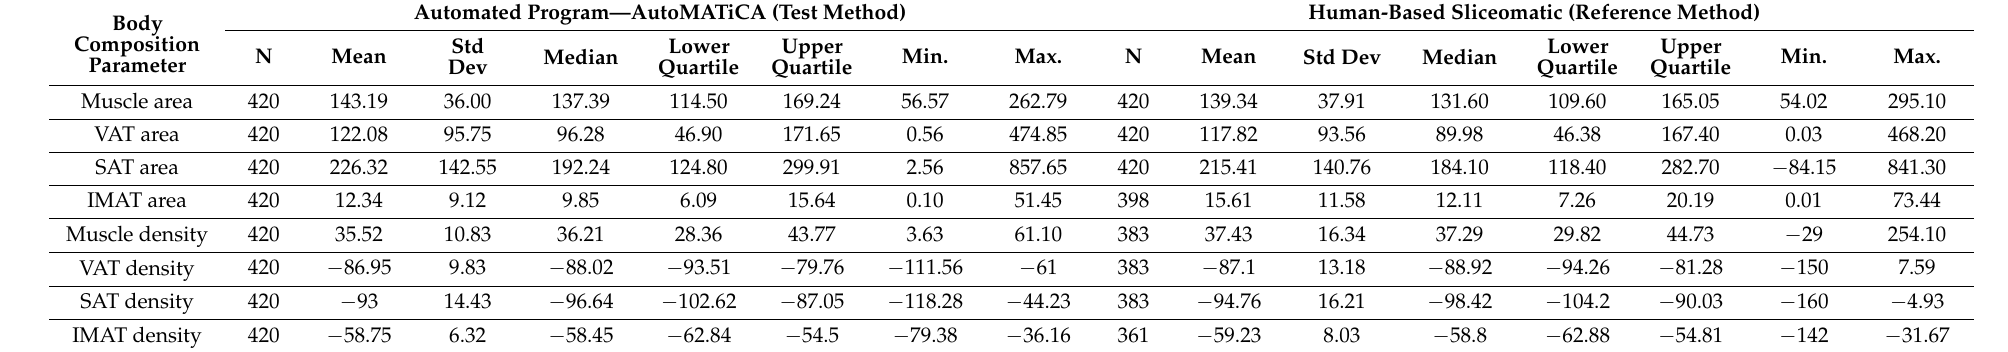
Table 2. Summary of body composition parameters following segmental tissue analysis using test and reference methods. Body